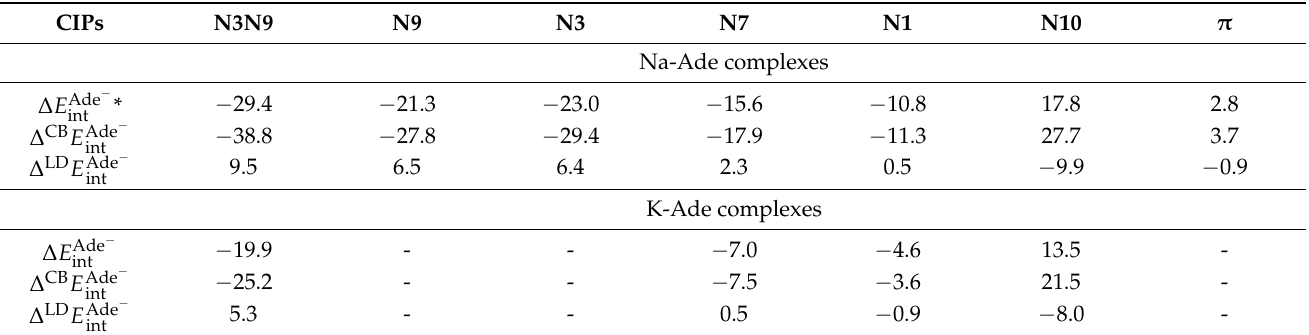
− ) and total LD-interactions ( ∆ LD E Ade int